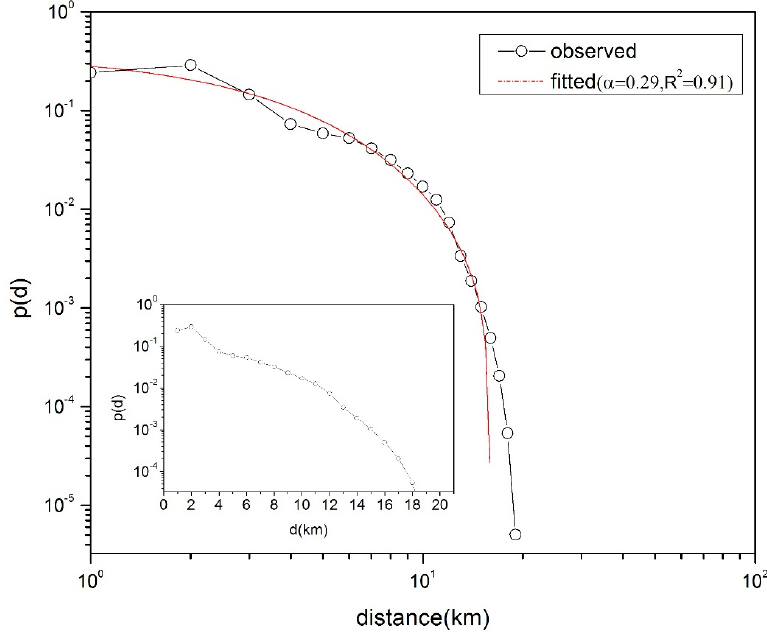
Figure 6. Profile of the distance decay function of all hospital visits.